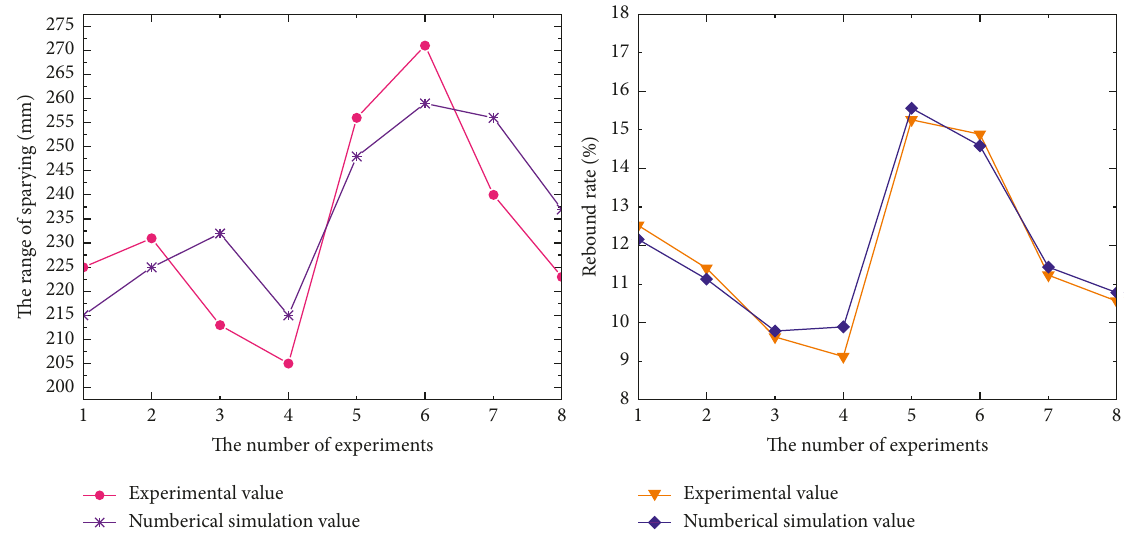
Figure 10: Curve of spray range and rebound